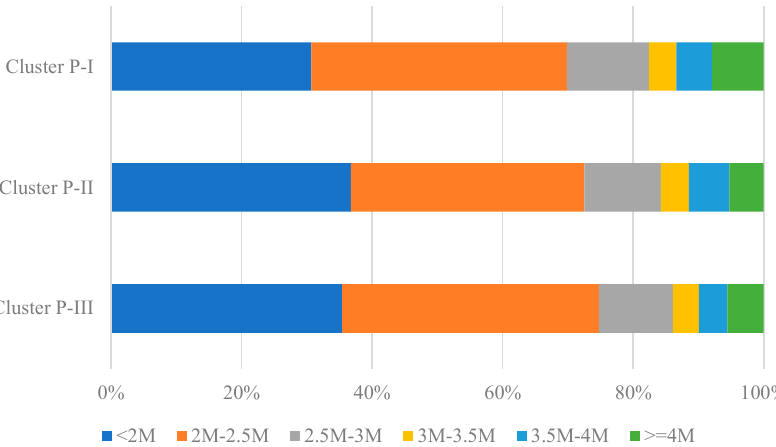
Figure 3. Percentages of HEVs by vehicle price category (in JPY) for each cluster.